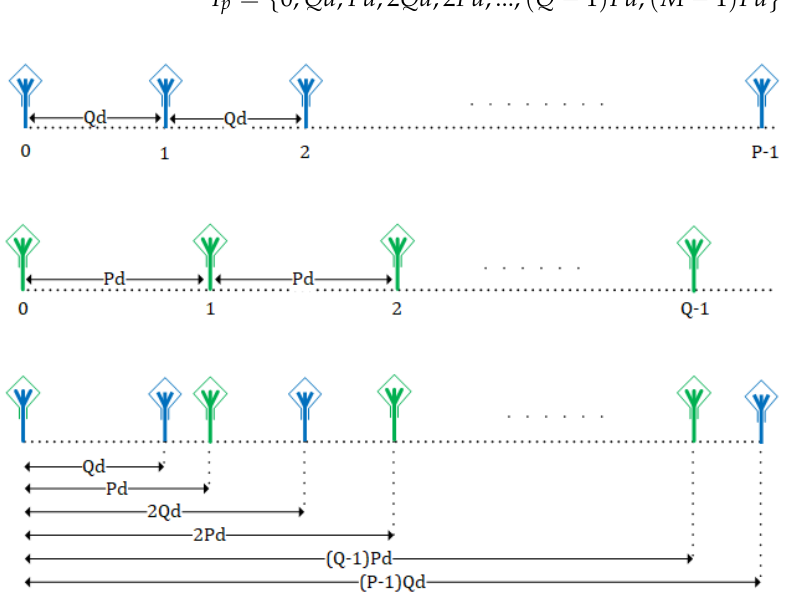
Figure 1. Generalized coprime antenna array